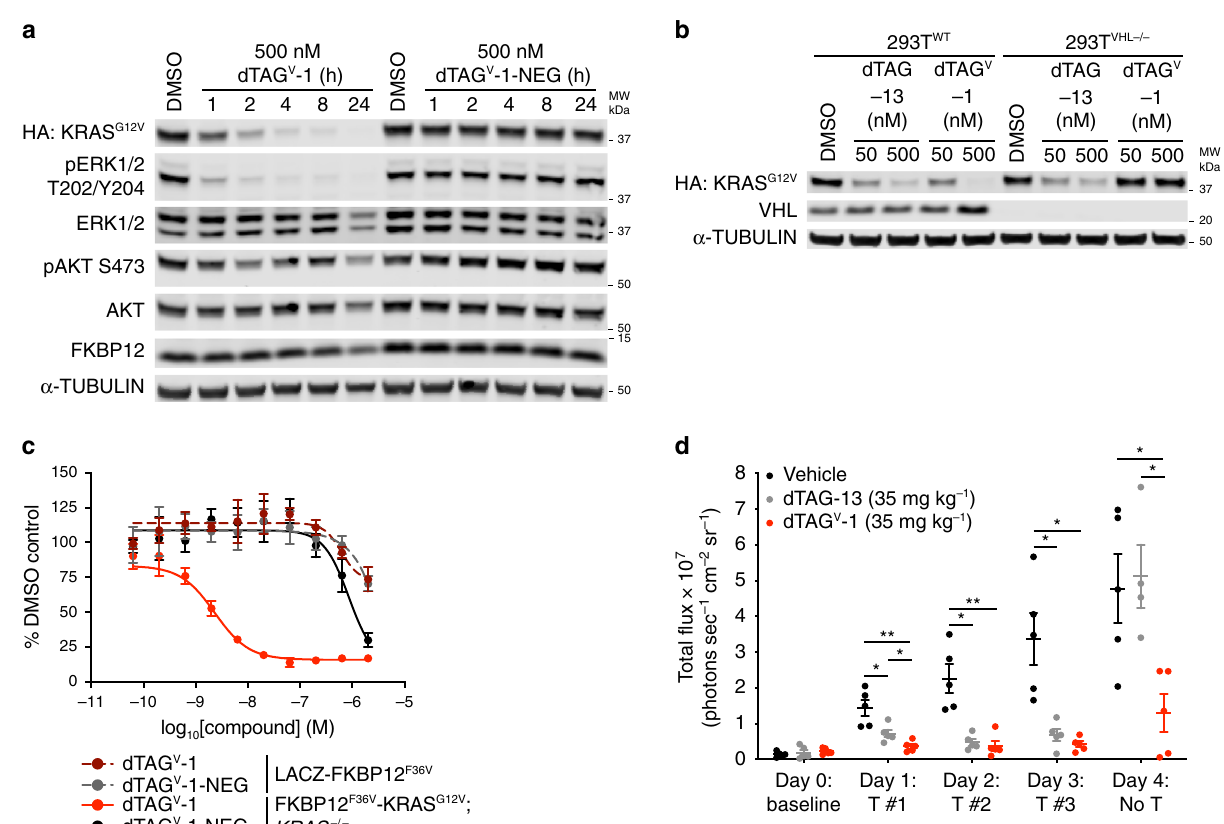
Fig. 2 dTAG V -1 is an in vivo-compatible degrader of FKBP12 F36V -tagged proteins. a Immunoblot analysis of PATU-8902 FKBP12 F36V -KRAS G12V ; KRAS − / − clone treated with DMSO, dTAG V -1, or dTAG V -1-NEG for the indicated time-course. b Immunoblot analysis of 293T WT FKBP12 F36V -KRAS G12V or 293T VHL-/- FKBP12 F36V -KRAS G12V cells treated with DMSO or the indicated dTAG molecules for 24 h. Data in a , b are representative of n = 3 independent experiments. c DMSO-normalized antiproliferation of PATU-8902 LACZ-FKBP12 F36V or FKBP12 F36V -KRAS G12V ; KRAS -/- clones treated with dTAG V -1 or dTAG V -1-NEG for 120 h. Cells were cultured as ultra-low adherent 3D-spheroid suspensions. Data are presented as mean ± s.d. of n = 4 biologically independent samples and are representative of n = 3 independent experiments. d Bioluminescent imaging to evaluate degradation of luciferase-FKBP12 F36V in mice was performed daily as follows: day 0 to establish baseline signal, day 1 – 3 to monitor luciferase-FKBP12 F36V signal 4 h after vehicle or dTAG molecule treatment (T), day 4 to monitor duration of luciferase-FKBP12 F36V signal 28 h after third and fi nal vehicle or dTAG molecule treatment. Total fl ux for each mouse is depicted. Data are presented from vehicle ( n = 5 biologically independent mice at day 0 – 4), dTAG-13 ( n = 5 biologically independent mice at day 0 – 3; n = 4 biologically independent mice at day 4) or dTAG V -1 ( n = 5 biologically independent mice at day 0 – 4) treated mice. P values are derived from a two-tailed Welch ’ s t -test (* P < 0.05, ** P < 0.01) and are provided as a Source Data fi le. Source data for a – d are provided as a Source Data fi